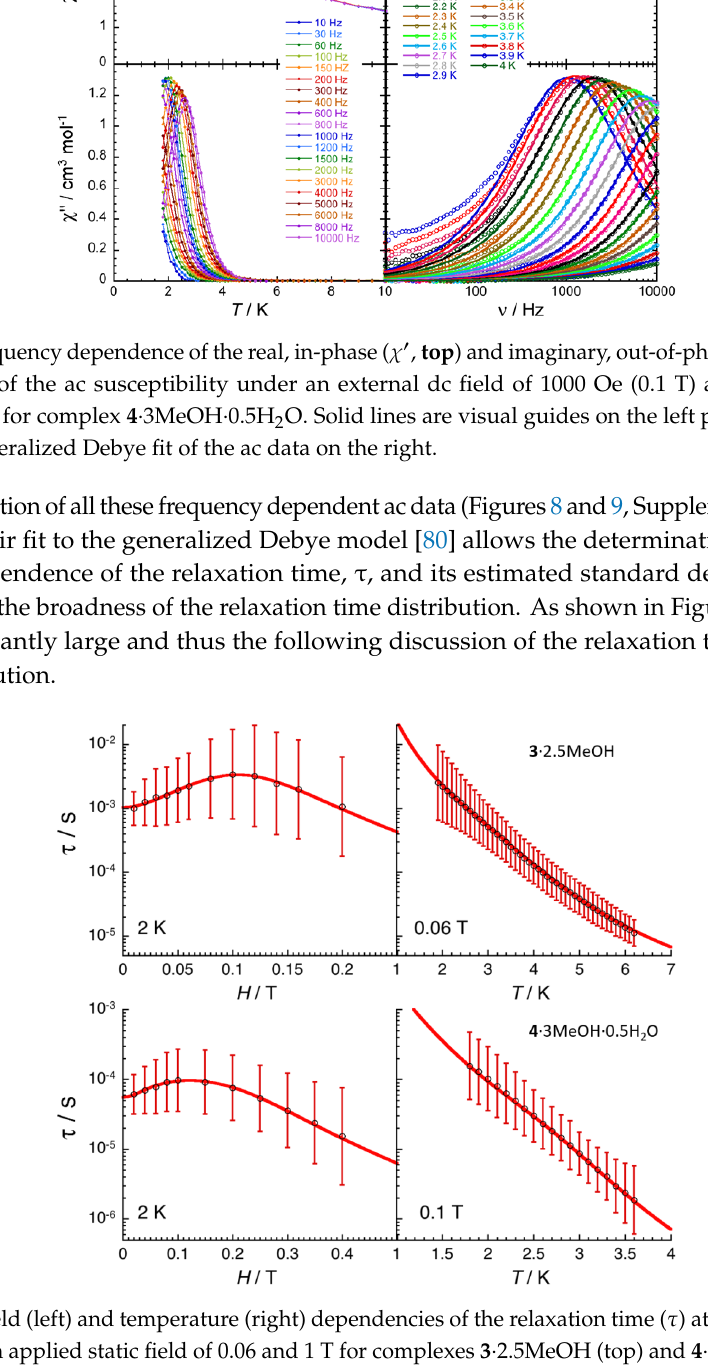
Figure 10. Field (left) and temperature (right) dependencies of the relaxation time ( τ ) at 2.0 K and in the presence of an applied static field of 0.06 and 1 T for complexes 3 · 2.5MeOH (top) and 4 · 3MeOH · 0.5H 2 O (bottom), respectively. The relaxation time was estimated from the generalized Debye fits of the ac susceptibility data shown in Figures 8 and 9, Figures S10 and S13. The estimated standard deviations of the relaxation time (vertical solid bars) have been calculated from the α parameters of the generalized Debye fit (Figures S11–S15) and the log-normal distribution as described in ref. [81]. The solid red lines are the best fit discussed in the text.